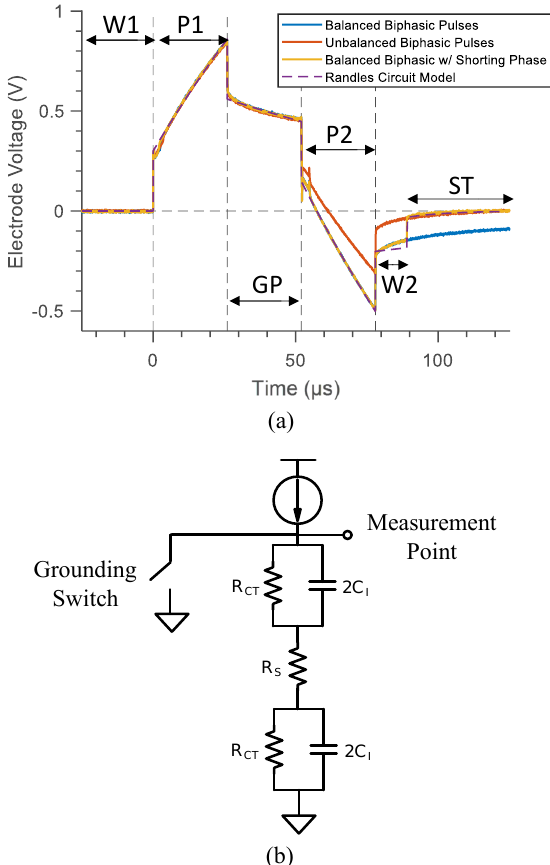
Figure 8. ( a ) In vitro measurement results with biphasic simulation pulses and ( b ) Randles circuit model of two series electrodes where I DAC = 275 µ A, C I = 10.4 nF, R S = 1.2 k Ω , and R CT = 11.2 k Ω